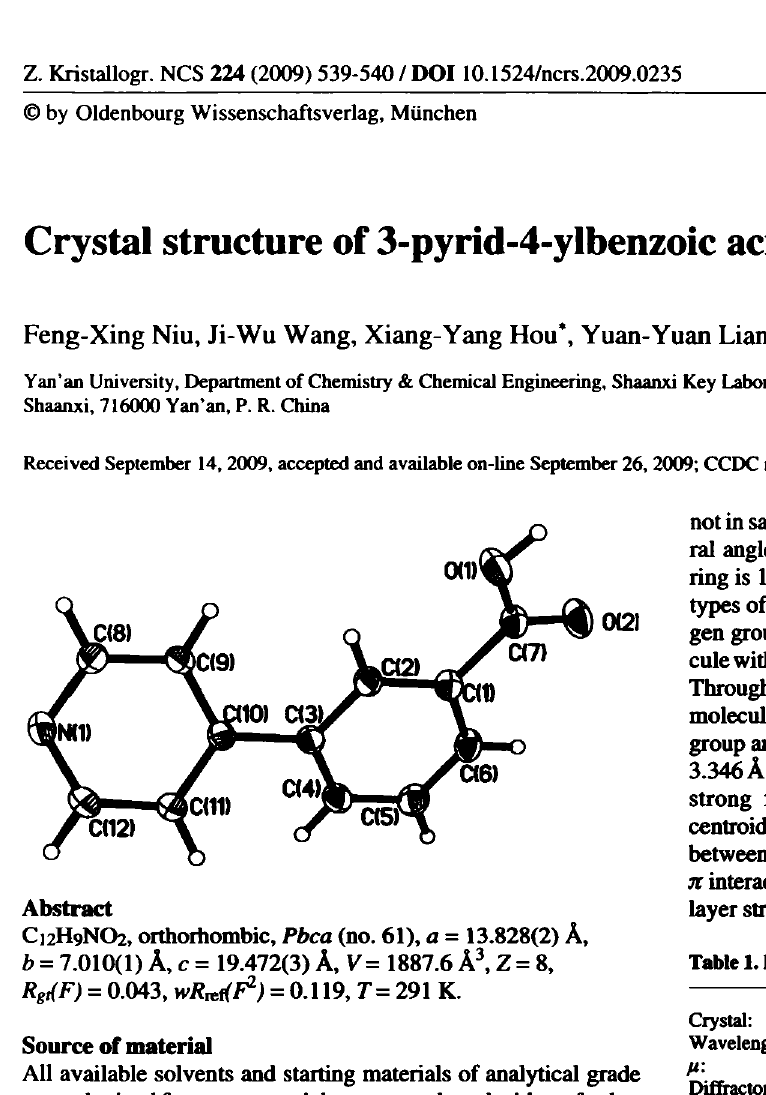
Table 2. Atomic coordinates and displacement parameters (in Â 2